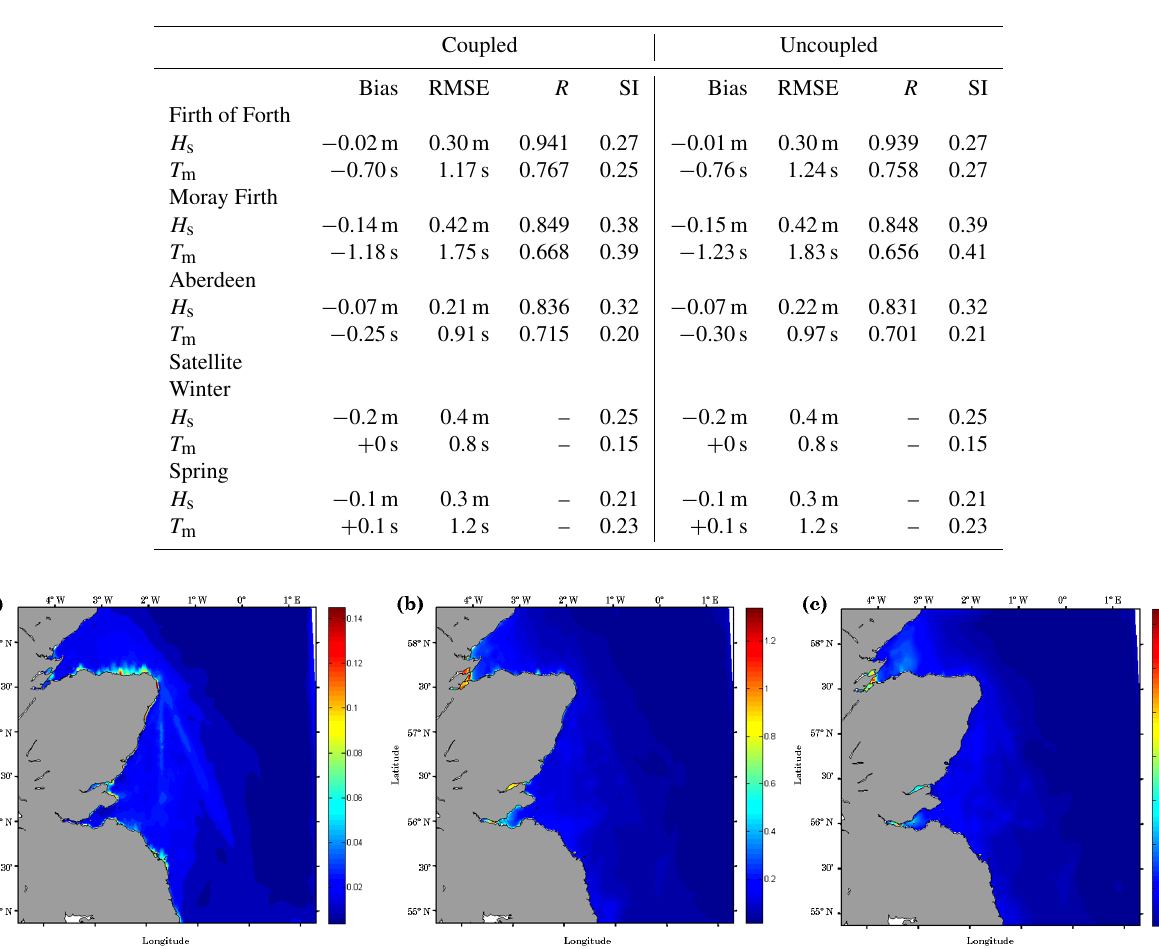
Table 4. Comparison between observed and modelled (both with and without WCIs implemented) wave heights and periods for wave gauges and satellite observations. The reported validation was carried out for 2010 (Firth of Forth and Moray Firth) and for 2008 (Aberdeen wave gauge and satellite observations). Details of the observation data are reported in Table 1 of the paper and in Table S2 of the Supplement.